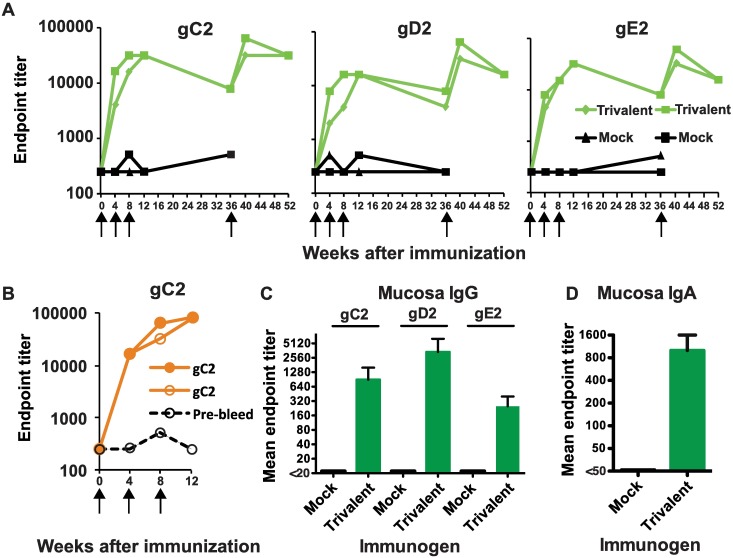
Rhesus ELISA antibody responses.(A) Plasma antibody endpoint titers induced by the trivalent vaccine. (B) ELISA antibody titers in animals immunized with gC2 alone. Each animal in (A) and (B) is shown separately. Arrows indicate immunizations. (C) Vaginal mucosa IgG gC2, gD2 and gE2 ELISA titers to the trivalent vaccine. (D) Vaginal mucosa IgA responses to the trivalent vaccine were tested against the three antigens, gC2, gD2 and gE2 added to a single well. Mock vaccine responses in (C) and (D) were evaluated after the third immunization at week 12, while trivalent vaccine responses were assessed after the booster dose at week 40. Results in (C) and (D) are the mean and SEM of two animals in each group.